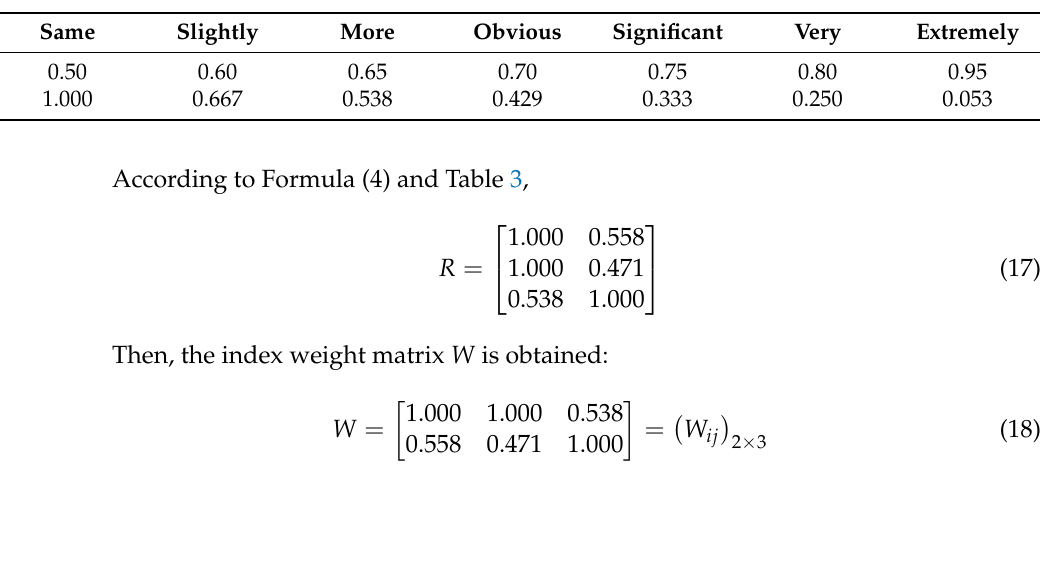
Table 4. Characteristic values of qualitative